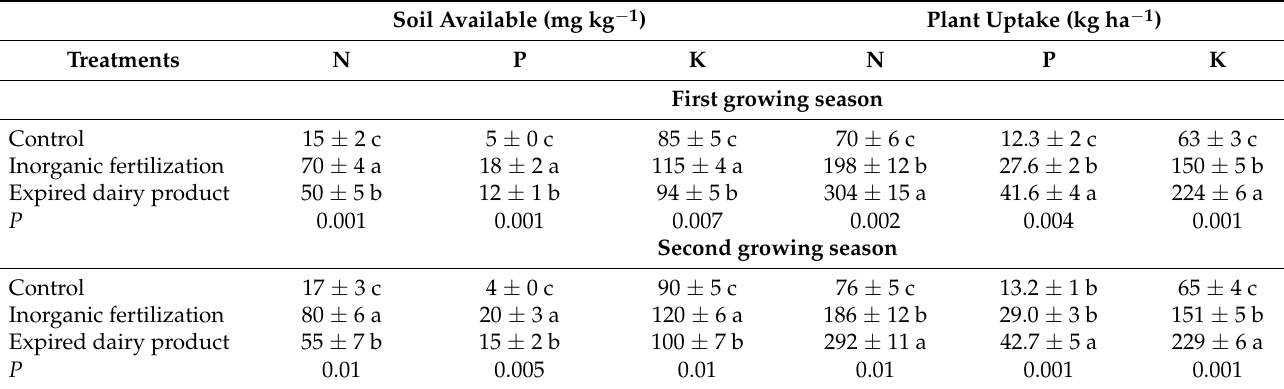
Table 3. Nutrients availability and uptake.